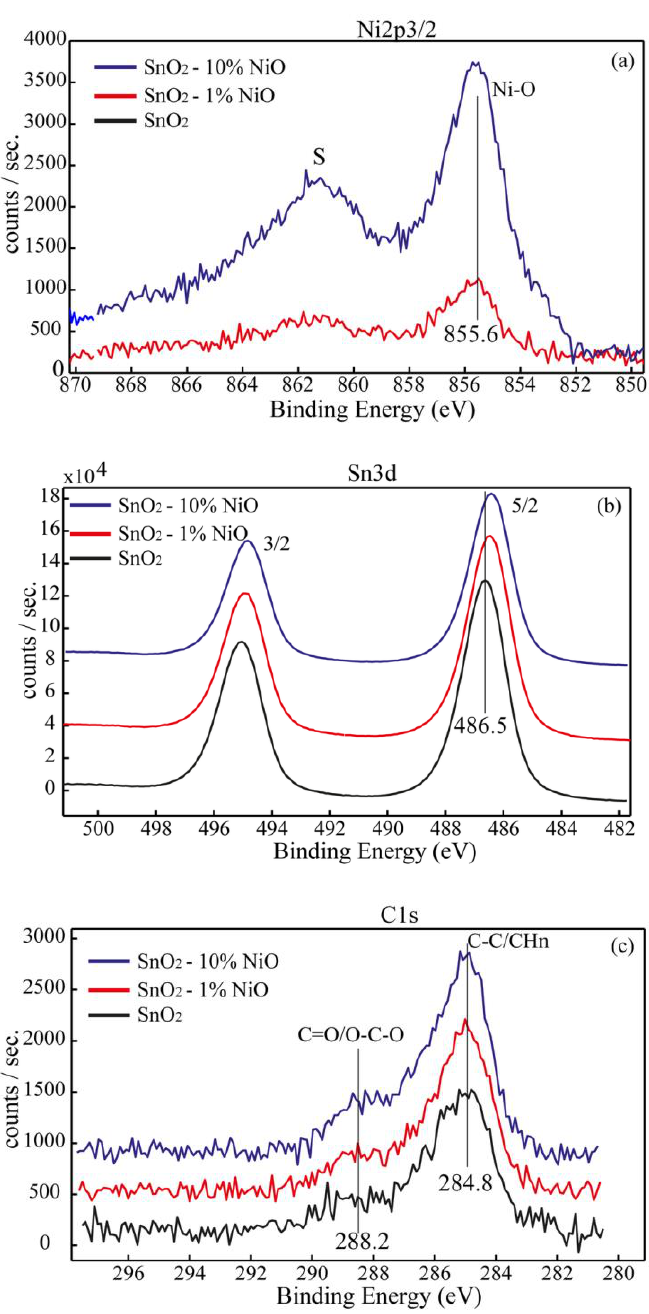
Figure 6. Ni2p3/2 ( a ), Sn3d ( b ) and C1s ( c ) superimposed spectra for SnO 2 , SnO 2 -1%NiO and SnO 2-10%NiO .